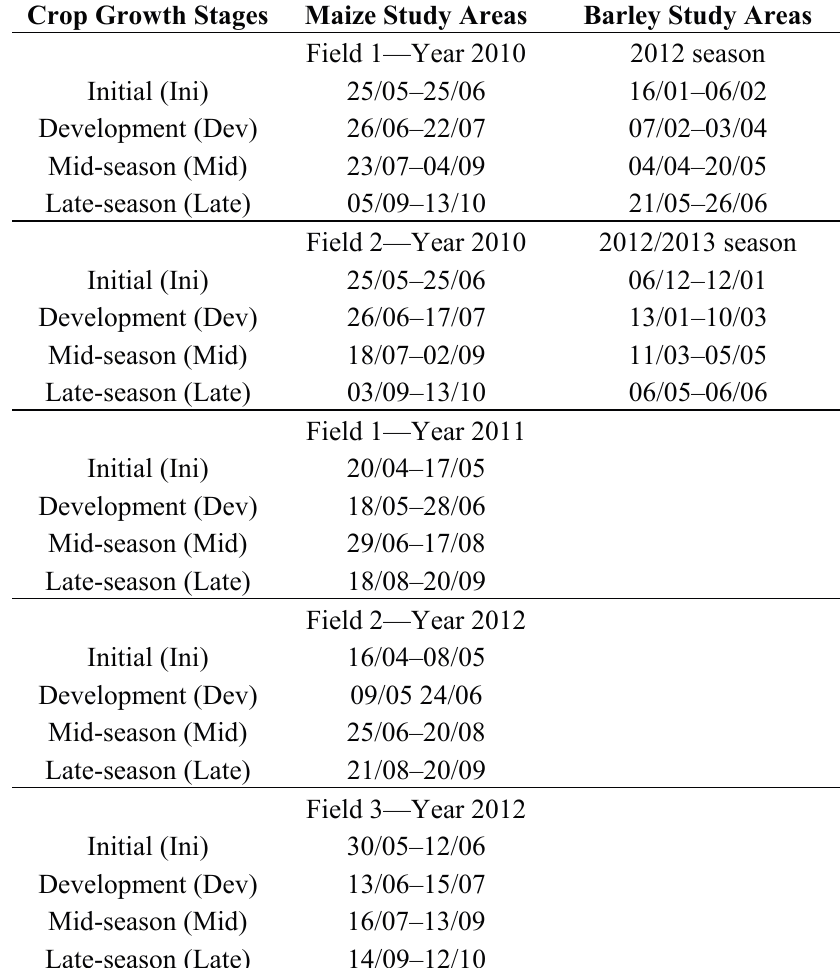
Table 1. Crop growth stages of maize and barley crops in each field and